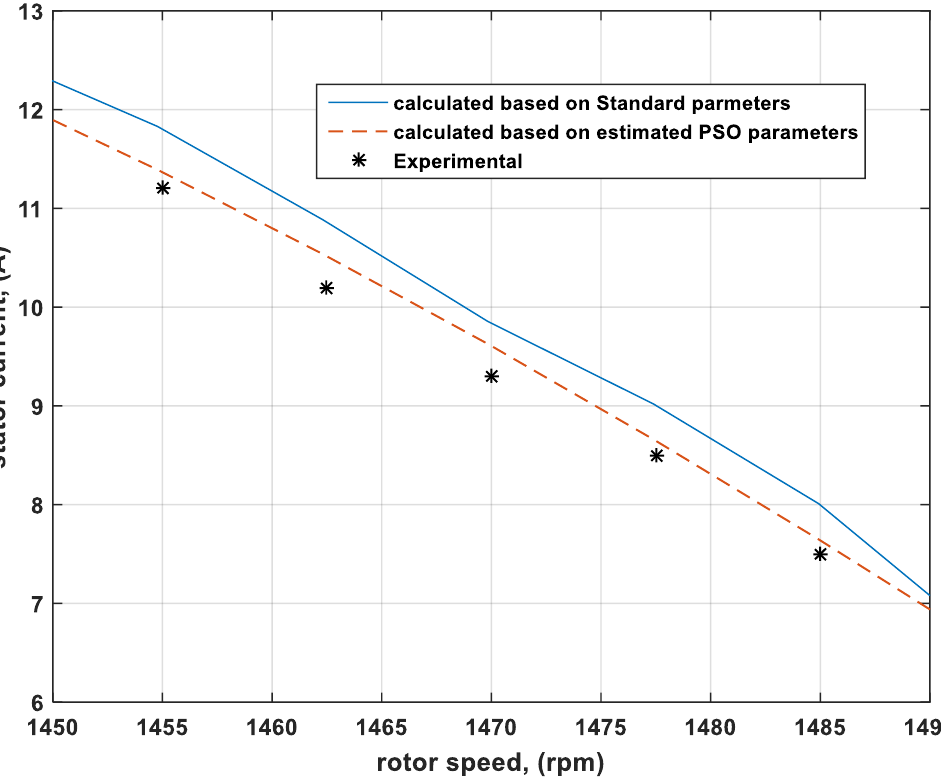
Figure 9. Variation of stator current versus motor speed.